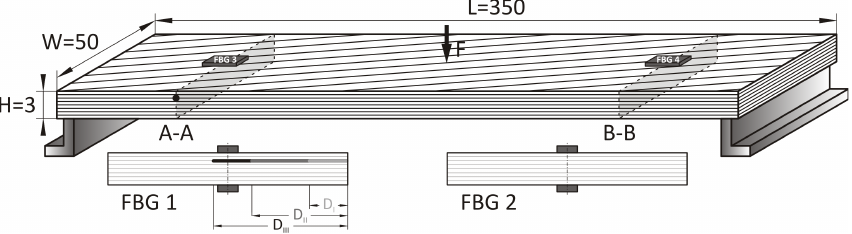
Figure 3. Details of composite specimen with cross-section views at sensor locations.